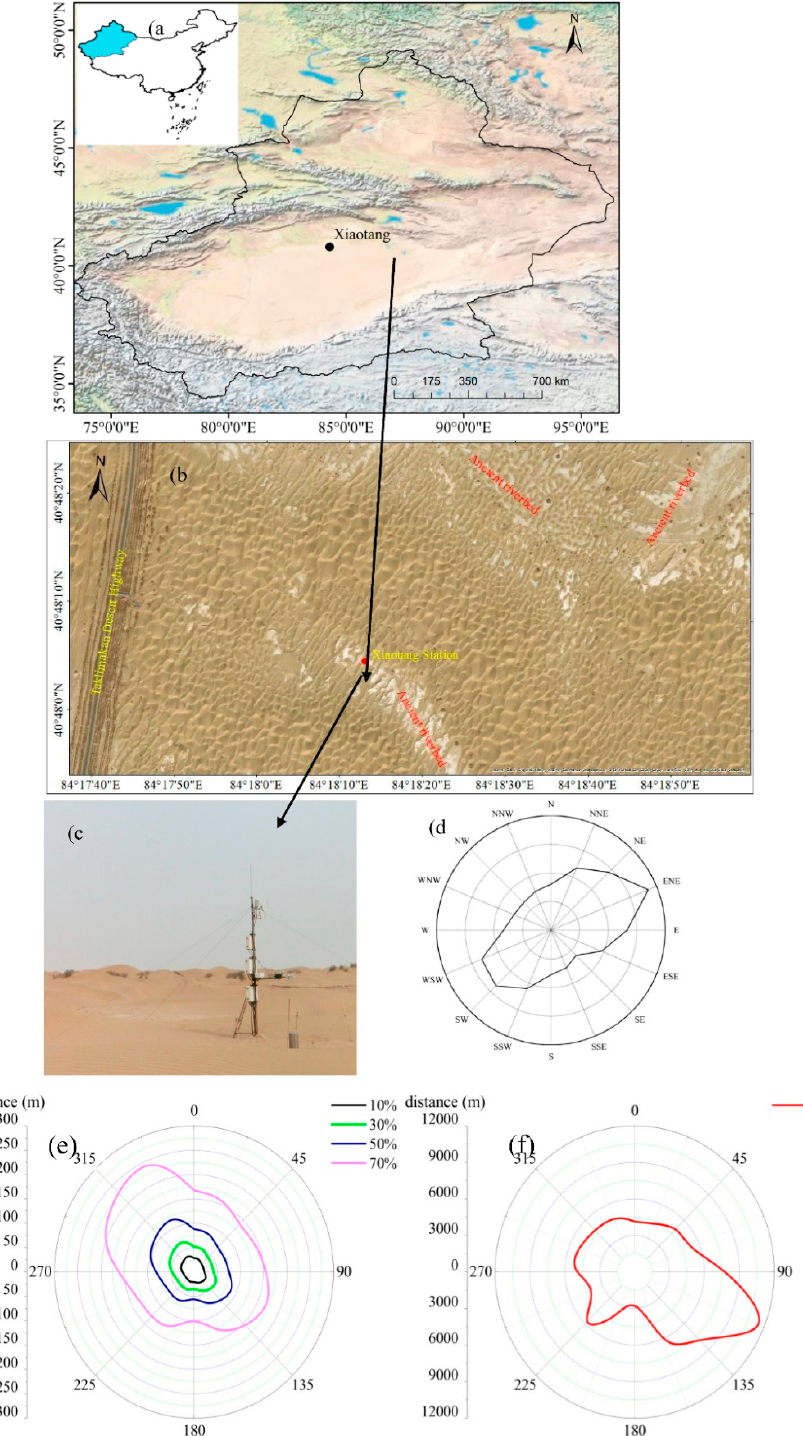
Figure 1. ( a ) Map of Xiaotang station in China and Xinjiang Province. ( b ) High resolution map of Xiaotang station. ( c ) Photograph of Xiaotang station in the Taklimakan Desert. ( d ) Wind direction at Xiaotang station during 5 January to 31 December 2010. ( e ) Flux footprint (10%, 30%, 50%, and 70%) at the observation station (concentric center), where the labels around the circle show the direction in geographical coordinates (0–360°) and the radius length of the circle is the distance. ( f ) Same as (e) but for 90%.